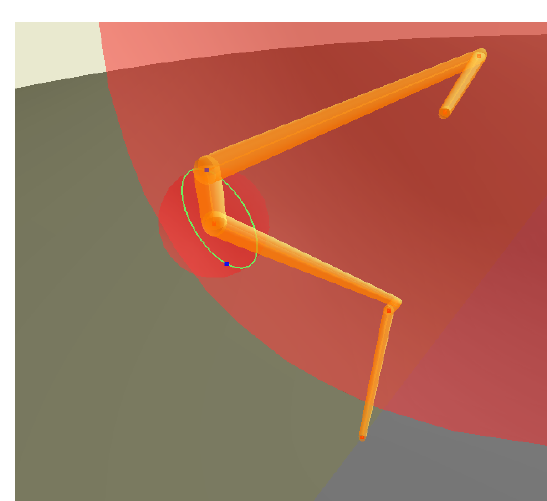
Figure 5: The robot and the geometric objects used to find P wx . The red spheres are S 2 and S w , the yellow plane is Π 1 x , the green circle is generated from C wx , and the blue point pair is Q wx , where one is picked to be P wx